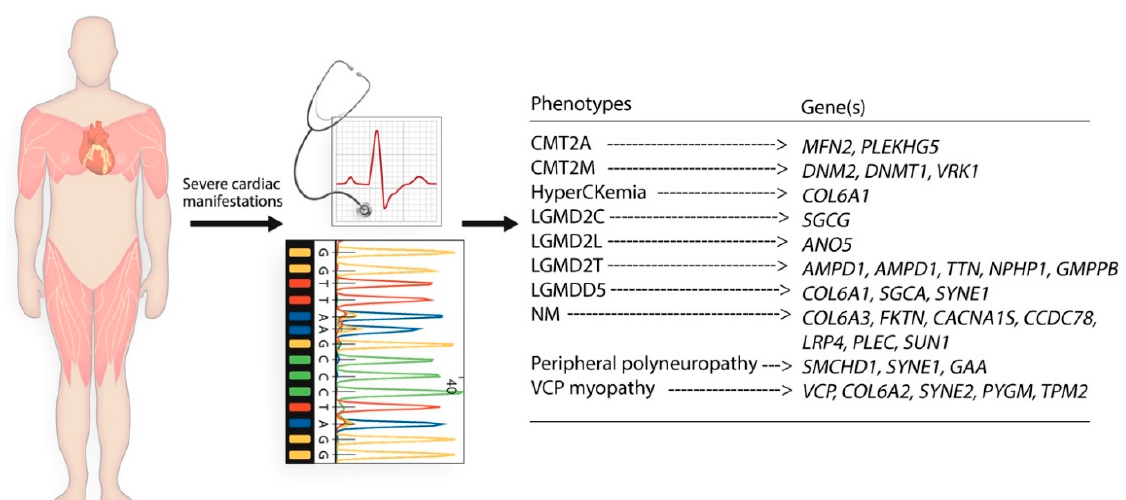
Figure 1. A schematic diagram demonstrates the outline of the retrospective studies defining different types of NMD and different genetic variants. Abbreviations: AMPD1 = Adenosine Monophosphate Deaminase 1; ANO5 = Anoctamin 5; CACNA1S = Calcium Voltage-gated Channel Subunit Alpha1 S; CCDC78 = Coiled-coil Domain Containing 78; CMT2A = Charcot-Marie-Tooth Type 2A; CMT2M = Charcot-Marie-Tooth Type 2M; COL6A1 = Collagen Type VI